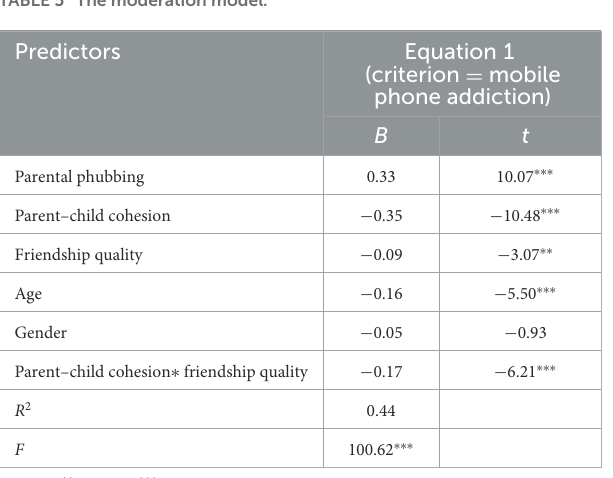
TABLE 5 The moderation